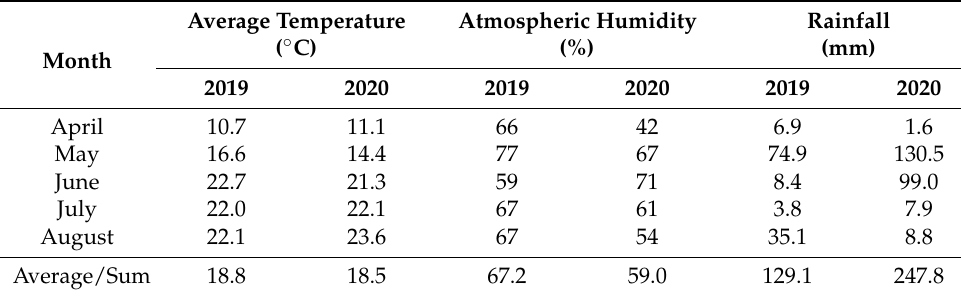
Table 1. Meteorological conditions during the